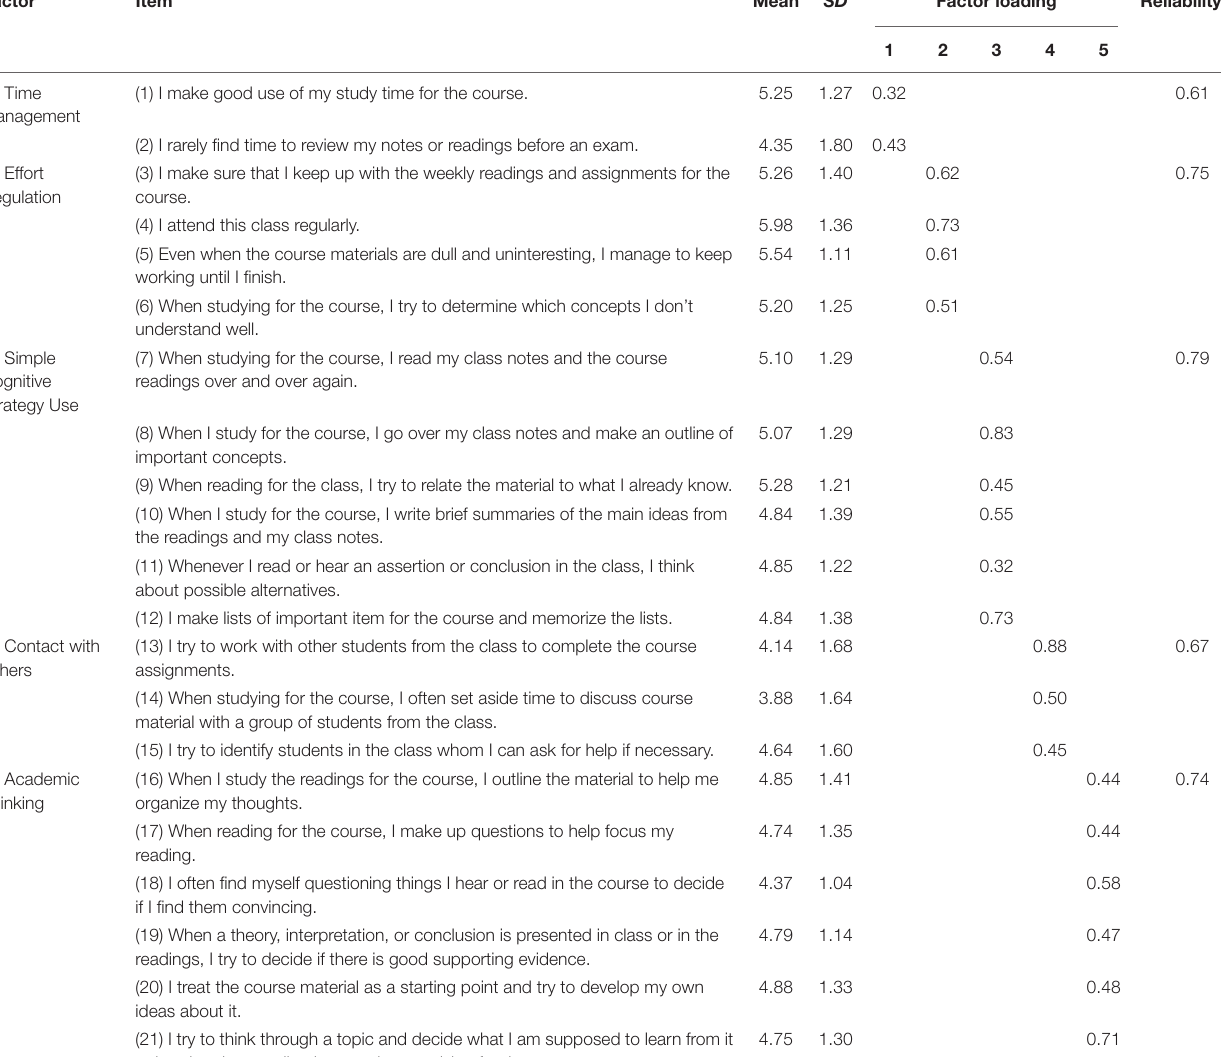
TABLE 2 | Exploratory factor analysis results for items of learning strategies. Factor